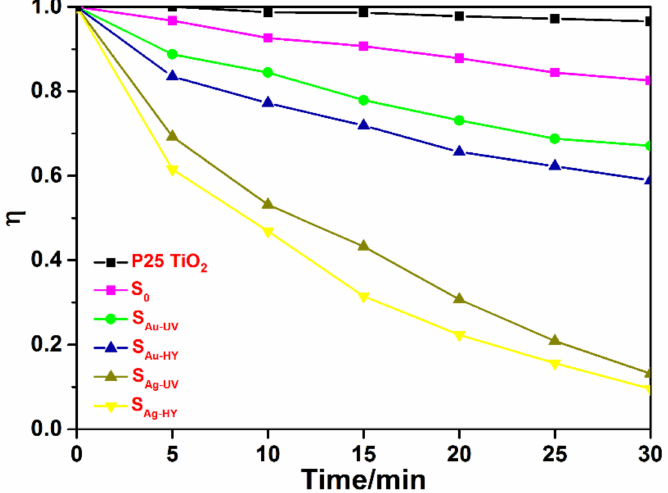
Figure 2. Photocatalytic degradation of RhB by TiO 2 membrane decorated with Ag and Au